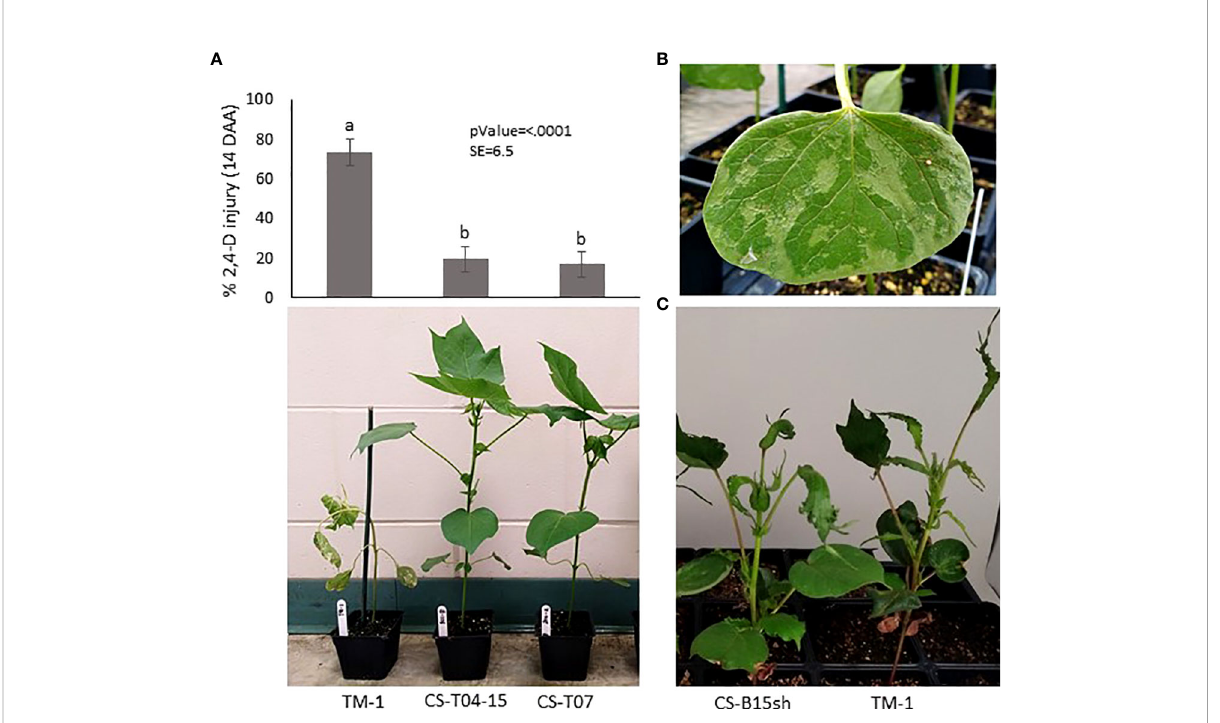
FIGURE 1 Herbicide injury and symptoms observed in the cotton accessions used in this study. (A) Response to 2,4-D observed on TM-1, CS-T04-15, and CS-T07 treated with 1x rate of 2,4-D in the greenhouse: Top, histogram of 2,4-D injury (mean) observed on 4-leaf stage cotton seedlings at 14 days after application (DAA), with four replications and four plants per replication; Bottom – visible 2,4-D injury of the representative individual plant at 7 DAA; (B) Close-up image of 2,4-D injury on seedling cotyledon of TM-1 after one day of treatment with 1x rate of 2,4-D; (C) Image shows reduced herbicide injury symptoms of CS-B15sh relative to TM-1 after 35 days from application of 0.75× rate of